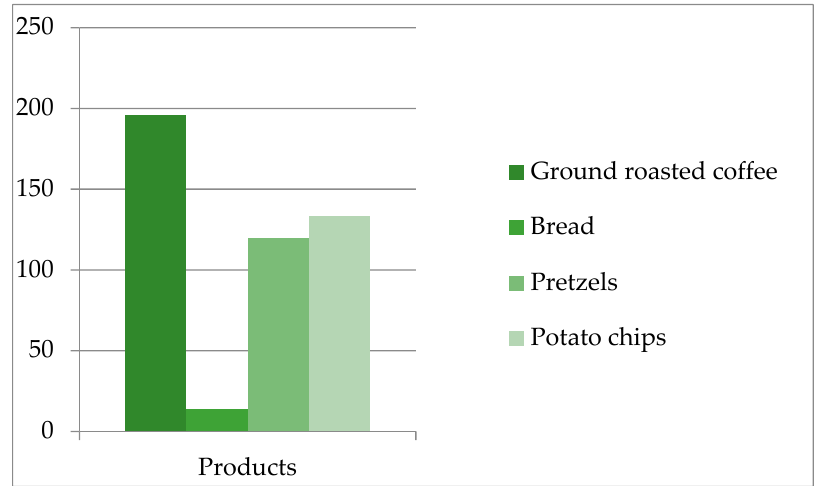
Figure 2. Acrylamide content of ground roasted coffee, bread, pretzels, potato chips (µg/kg).